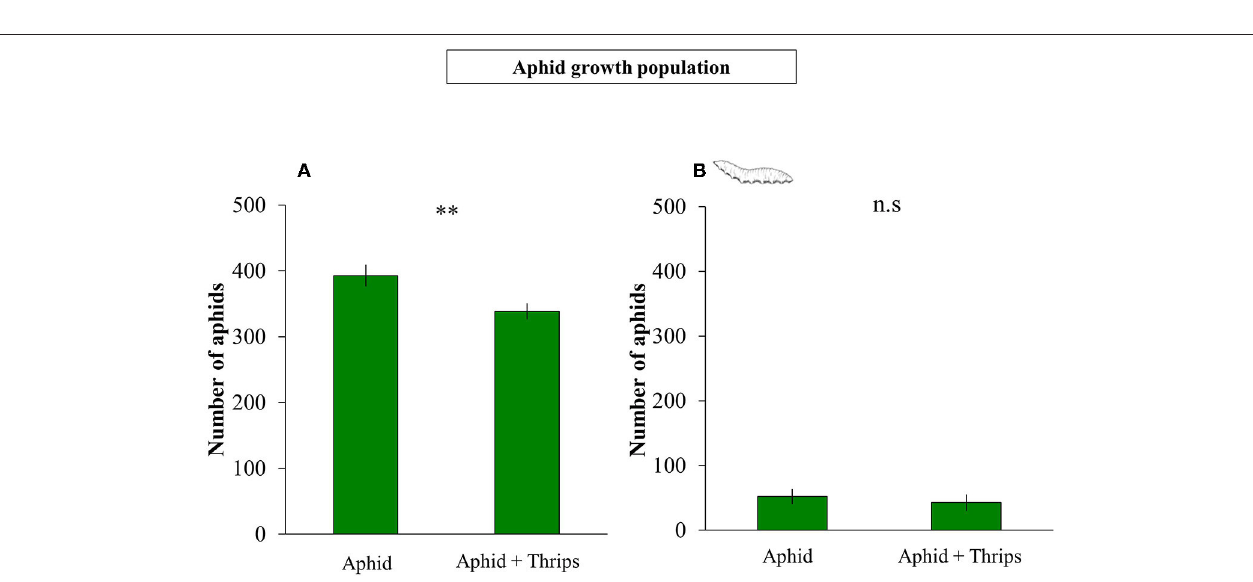
FIGURE 2 | Number of aphids on plants infested with aphid vs. aphid + thrips after: (A) 1 week of herbivore infestation; (B) development of S. rueppellii larvae feeding on infested plants until pupal stage. Bars represent means ± SE ( n = 20 replicates). Asterisks indicate significant differences between infestation treatments: ** P < 0.01, n.s not significantly different ( P > 0.05, GLM